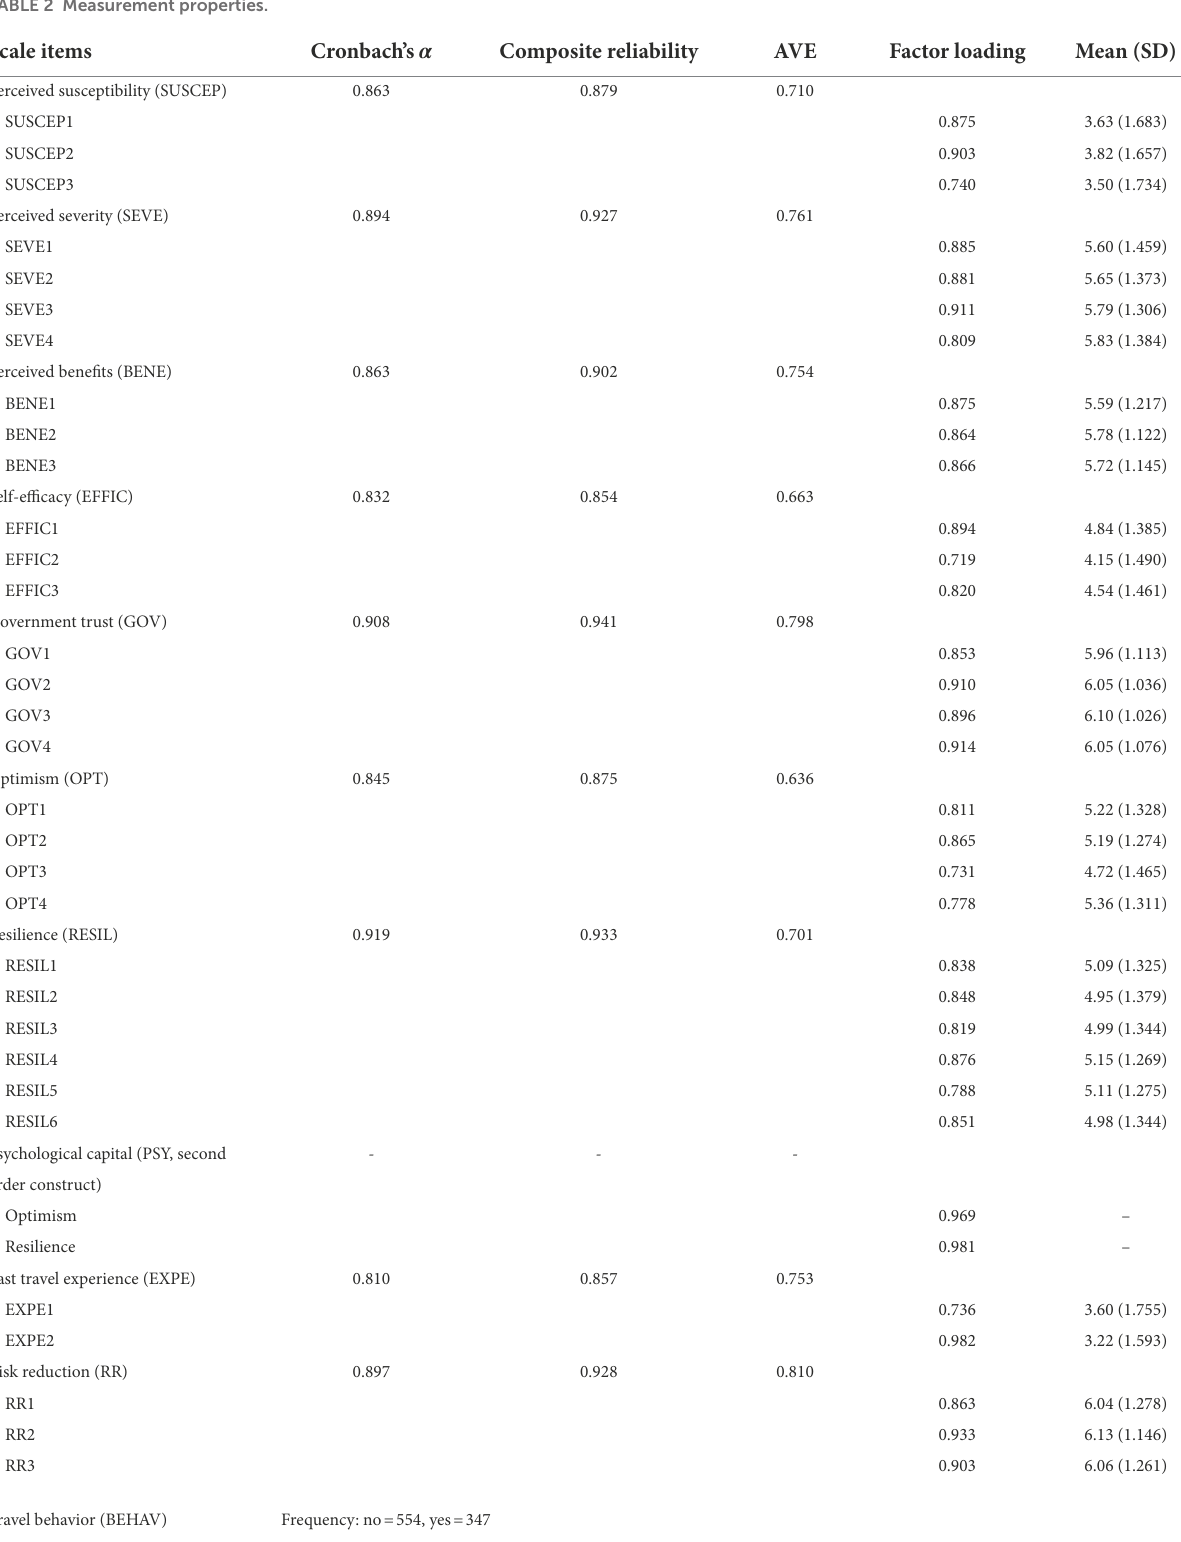
TABLE 2 Measurement